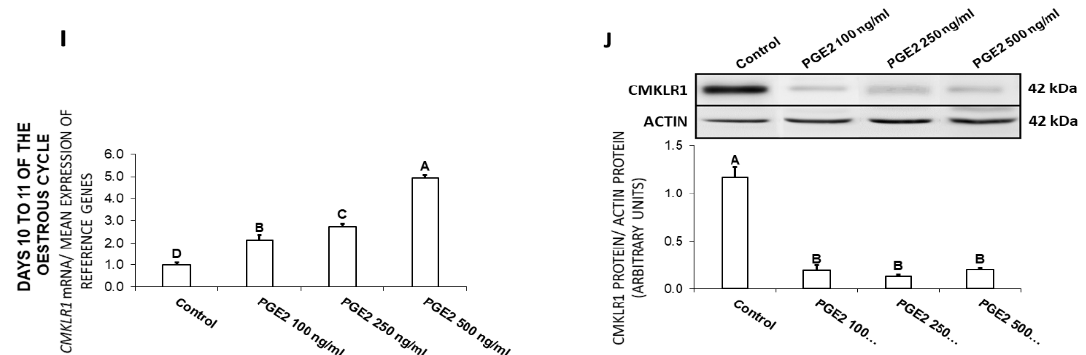
Figure 2. The influence of prostaglandin E 2 (PGE 2 ; 100, 250, 500 ng / mL) on chemokine-like receptor 1 (CMKLR1) mRNA ( A , C , E , G , I ) and protein ( B , D , F , H , J ) expression in the porcine endometrium on days 10 to 11, 12 to 13, 15 to 16, and 27 to 28 of the pregnancy, and on days 10 to 11 of the estrous cycle. The gene expression was determined by quantitative real-time PCR. The protein concentration was determined by the western blotting analysis; upper panels: Representative immunoblots; lower panels: Densitometric analysis of CMKLR1 protein relative to actin protein. Results are reported as the means ± S.E.M. ( n = 5). Bars with di ff erent superscripts di ff er ( p < 0.05). 2.3. The E ff ect of PGE 2 on GPR1 Gene and Protein Expression in the Endometrial Tissue Explants